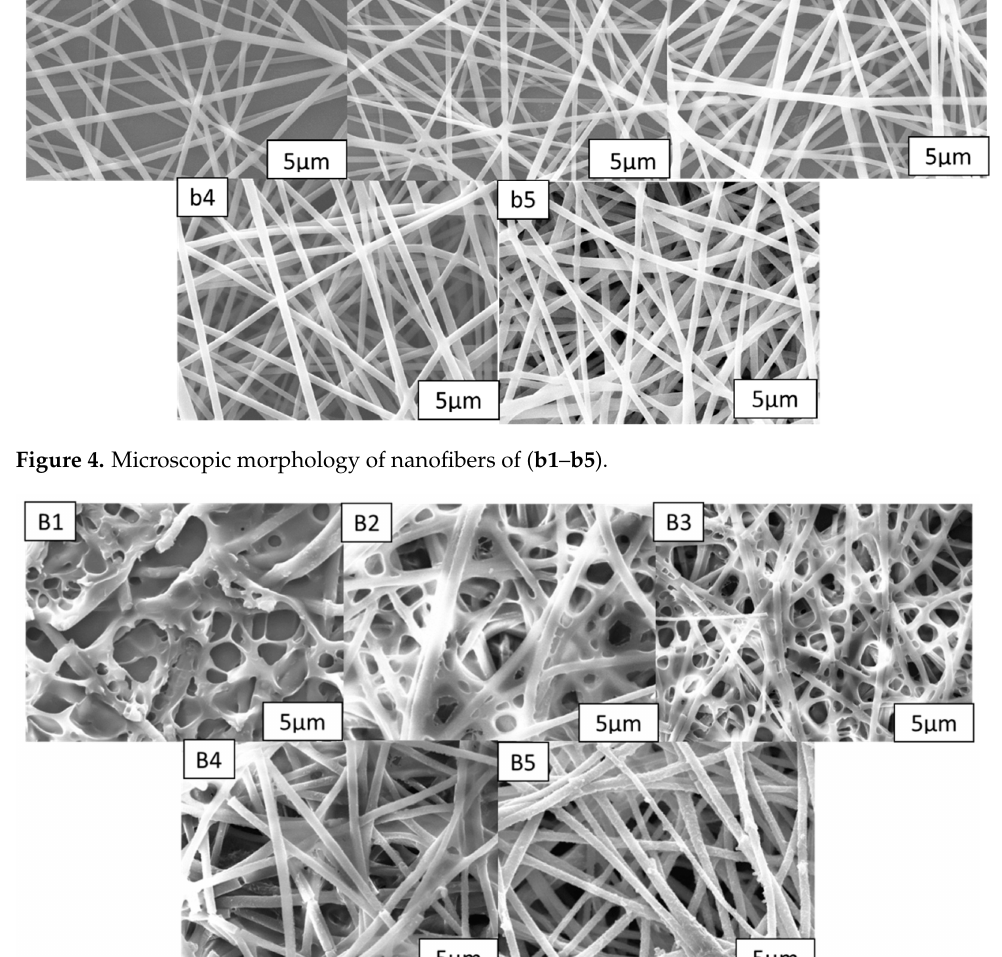
Figure 5. Network of the polymer matrix of ( B1 – B5